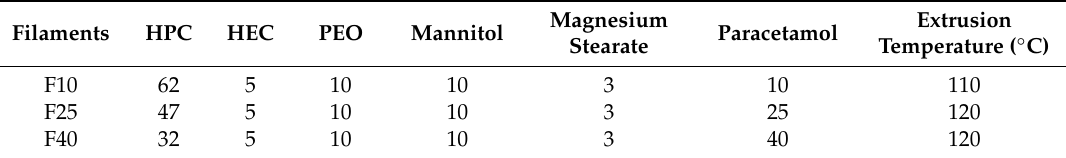
Table 1. Compositions (% w / w ) of the hot melt extruded